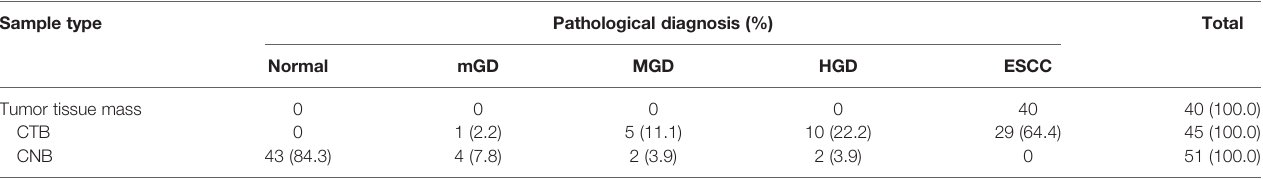
TABLE 3 | The results of pathological diagnosis of all 136 SSM samples taken from 40 surgical ESCC mass samples. Sample type